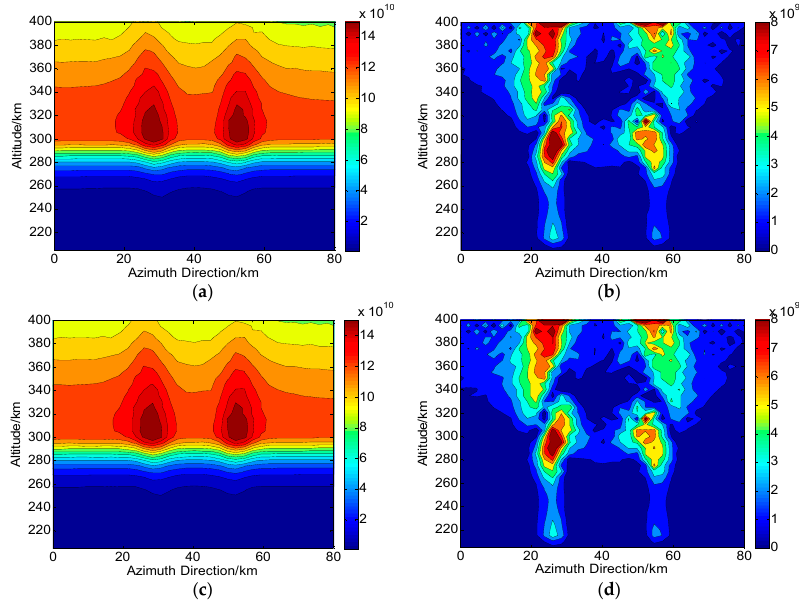
Figure 13. Two-dimensional CIT reconstructions under the condition of channel amplitude imbalance in Changbai ( Ω C is used). ( a , c ) are the reconstructed results with 0.1 dB and 0.5 dB, respectively. ( b , d ) are the corresponding absolute deviations between the true and reconstructed results. The unit of the electron density is electrons · m − 3 .